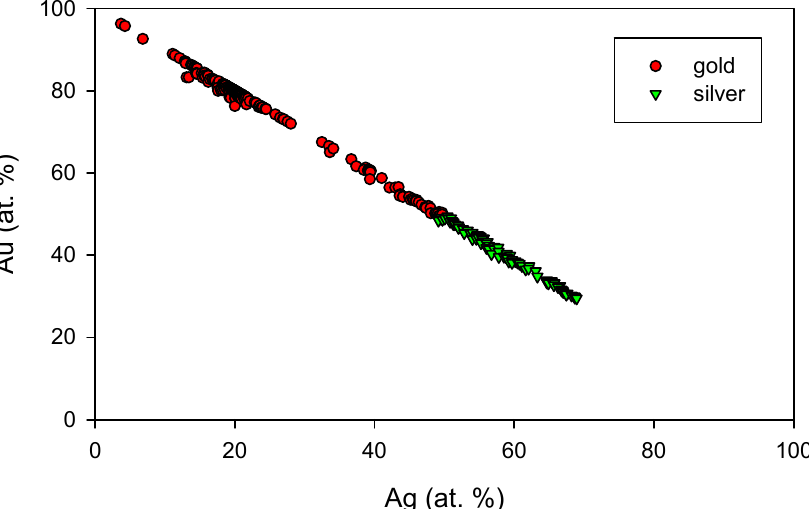
Figure 13. Chemical composition of members of Au-Ag solid-solution in an Ag versus Au (at. %) plot.